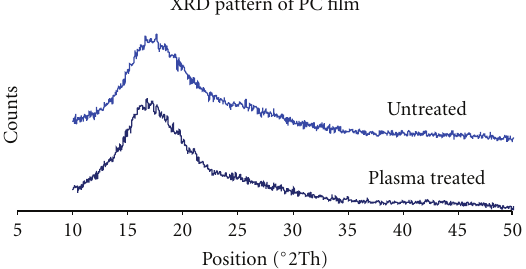
Figure 5: XRD spectrum of untreated and plasma-treated PC